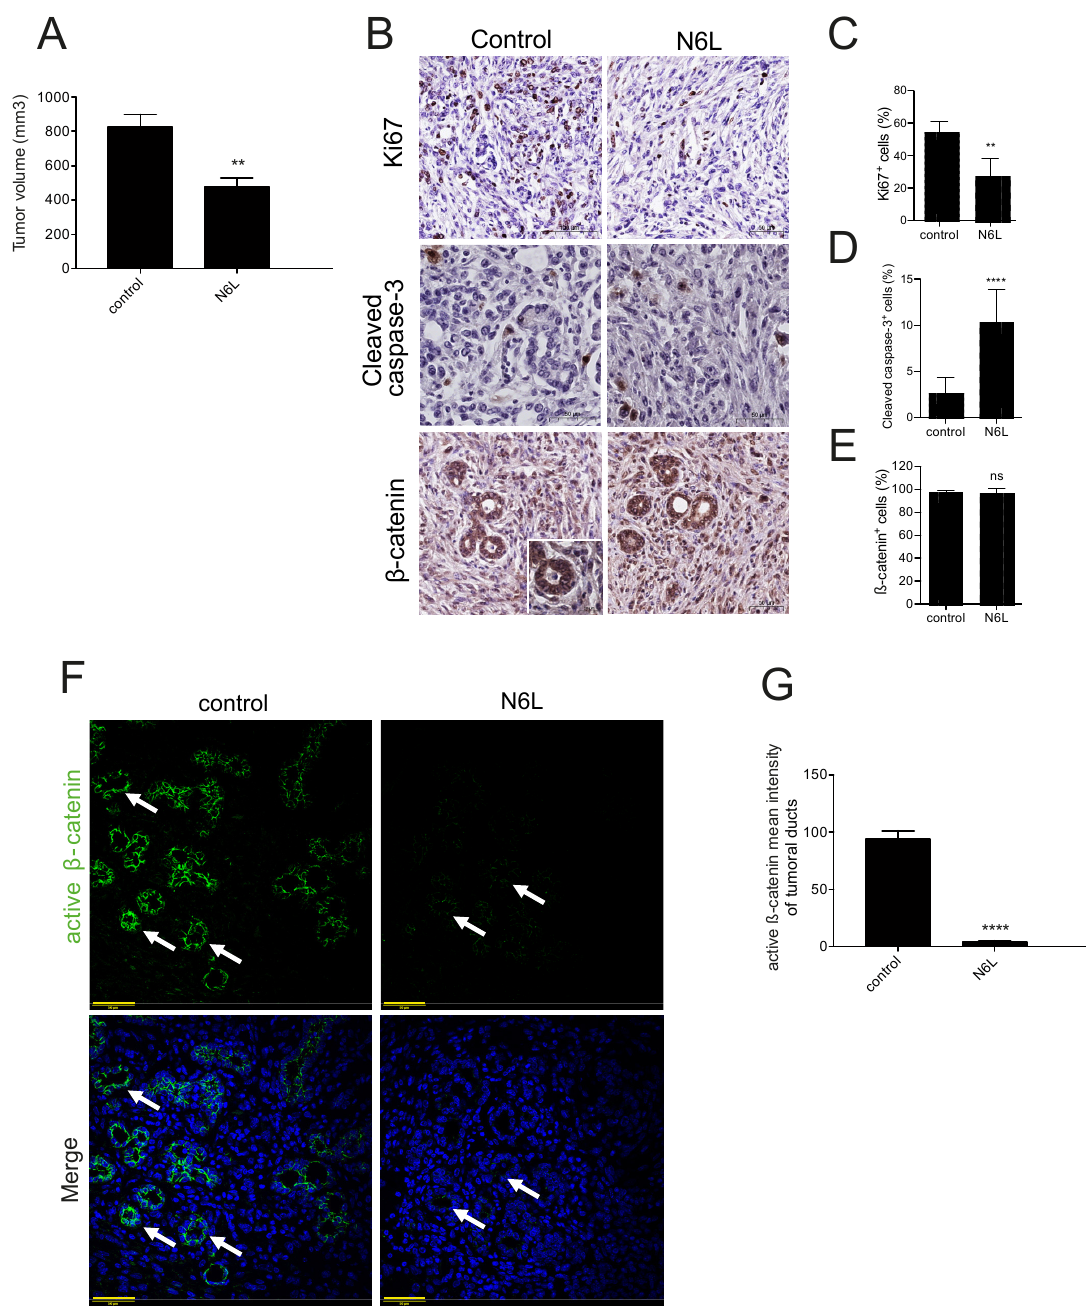
Figure 6. N6L inhibits Wnt/ β -catenin pathway in PDAC murine model. mPDAC cells were injected into the pancreas of FVB/n mice, mice were treated with N6L and sacrificed after 3 weeks. ( A ) The volume of mPDAC tumors was measured (Student’s t test ** p < 0.01). ( B ) Sections of mPDAC tumors were immunostained by using anti-Ki67, anti-cleaved caspase 3 or anti- β -catenin. The percentage of positive cells for each staining is shown in the graph ( C–E ) (Student’s t test ** p < 0.05, **** p < 0.001, n = 4). ( F ) Sections of mPDAC tumors from mice treated with N6L or with PBS as control were stained by immunofluorescence with an anti-active β -catenin antibody (green) and DAPI for nuclei (blue). The intensity of active β -catenin staining is weaker in tumor ducts of tumors treated with N6L than the control. ( G ) Quantification of the mean grey value of active β -catenin staining in mPDAC tumoral ducts of control ( n = 36) and N6L ( n = 10) treated mice (Student’s t test **** p < 0.001). Scale bars: 50 μ M.